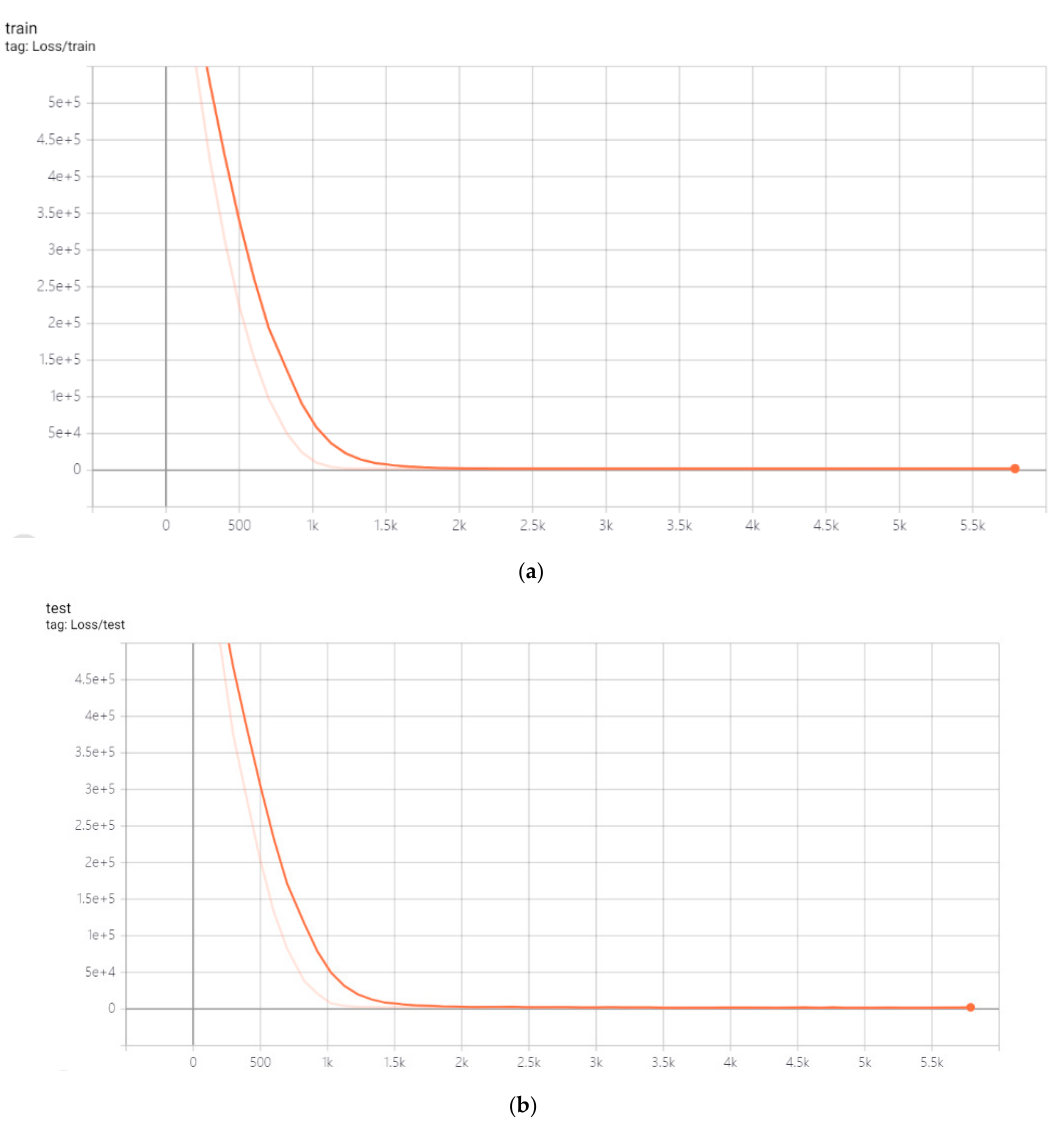
Figure 8. ( a ) The change of cross-entropy loss with training times during training. ( b ) The change of cross-entropy loss with training times during testing.